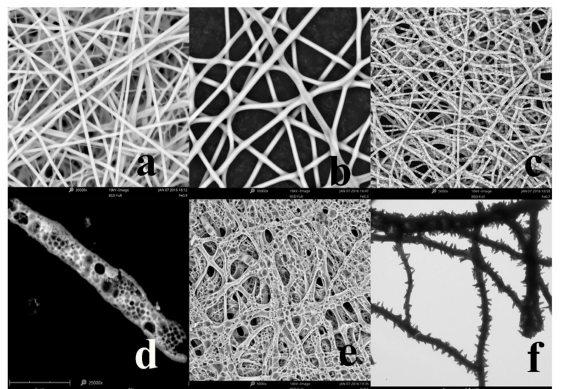
Figure 4. SEM and TEM images of the complex oxide nanofibers with di ff erent compositions: ( a ) SEM of GdNiO 3 , ( b ) SEM of Gd 0.9 Sr 0.1 NiO 3 , ( c ) SEM of Gd 0.7 Sr 0.3 NiO 3 , ( d ) SEM of a selected Gd 0.7 Sr 0.3 NiO 3 fiber at a higher magnification, ( e ) SEM of Gd 0.5 Sr 0.5 NiO 3 , ( f ) TEM image of Gd 0.3 Sr 0.7 NiO 3 . Reprinted with permission from [52]. Copyright © 2020 Elsevier